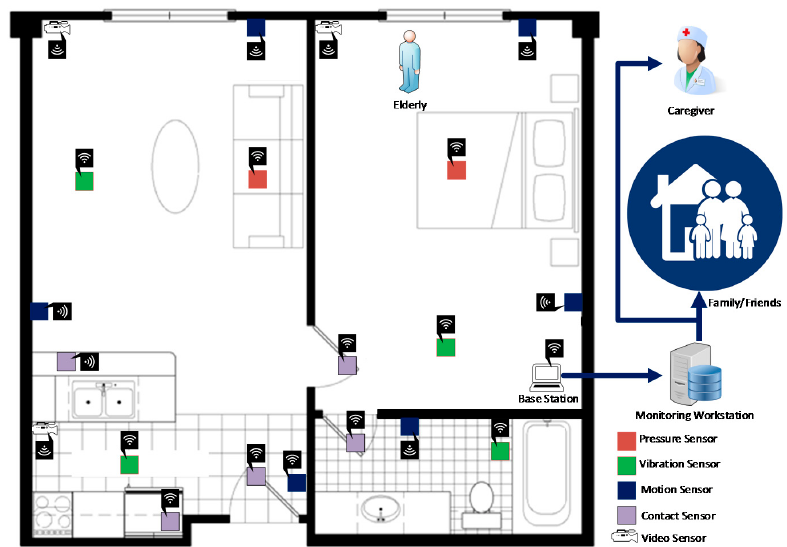
Figure 4. Sample schematic setup of a smart apartment for elderly care based on different ambient sensors.